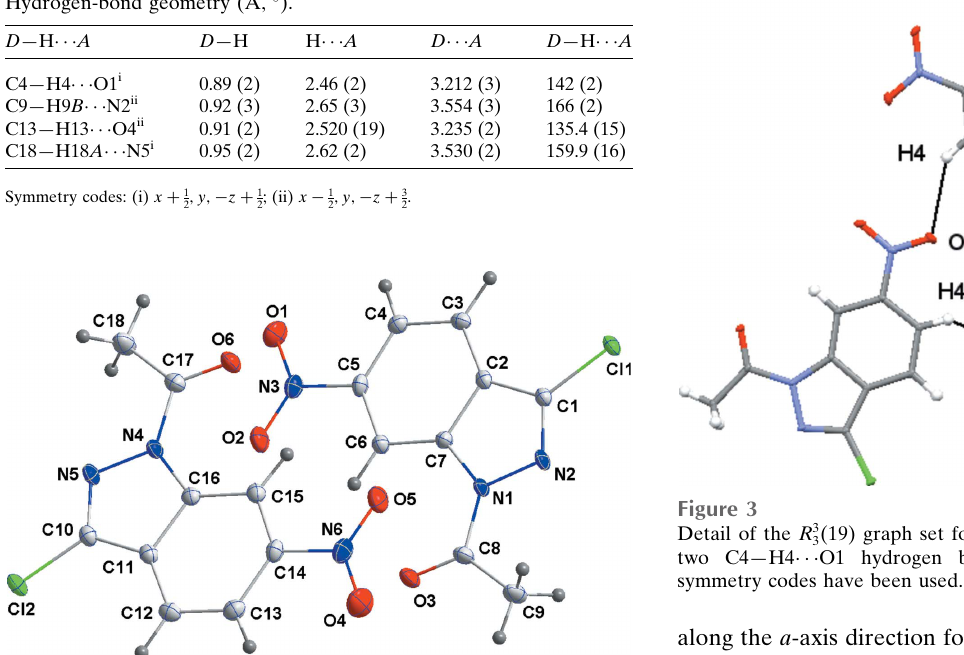
Fig. 3, an R 3 (19) graph set is formed by two C—H (cid:2) (cid:2) (cid:2) O 3 hydrogen bonds and one Cl (cid:2) (cid:2) (cid:2) O interaction for the molecule in the general position. A corresponding set is formed with the molecule in the special position.